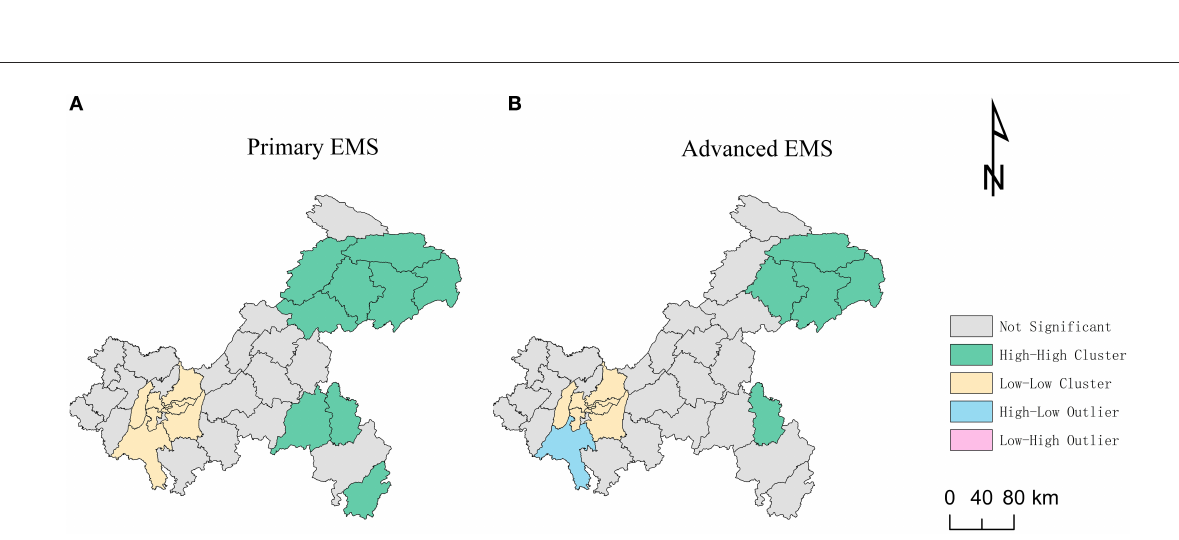
FIGURE6 Local indicators of spatial association (LISA) of the shortest travel times: (A) Primary emergency medical services (EMS). (B) Advanced